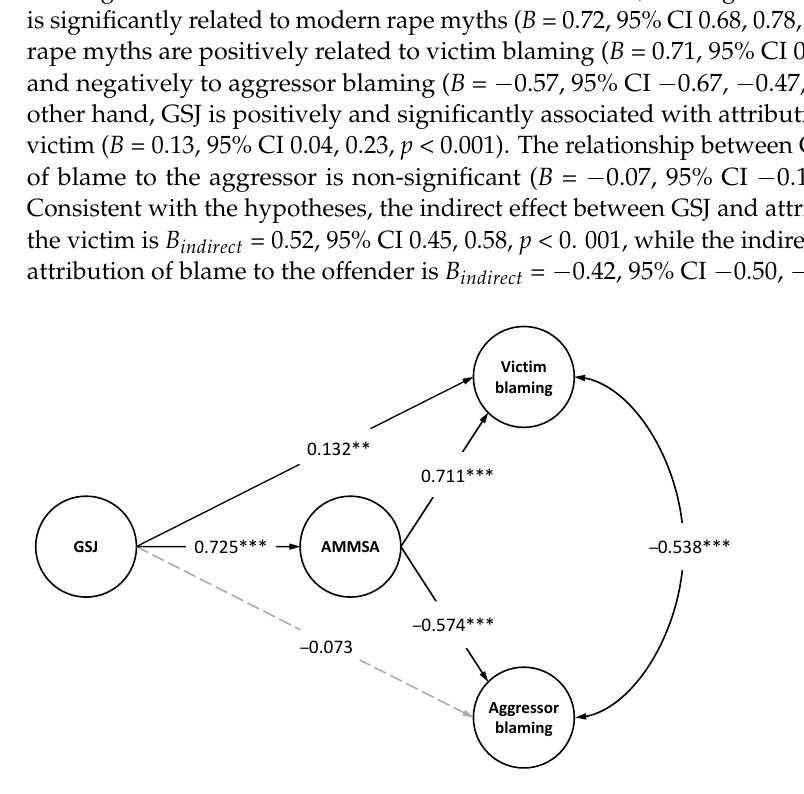
Figure 2. GSJ and attribution of blame to the victim and the aggressor, mediated by modern rape myths; Standardized values, ** < 0.01, *** <